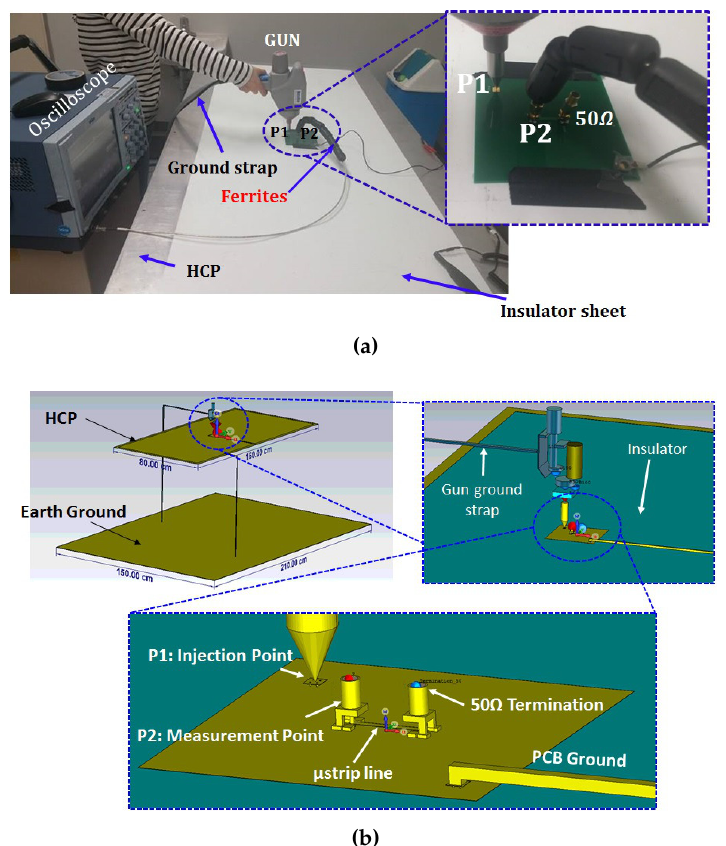
Figure 3. ESD coupled noise analysis for µ -strip line PCB: ( a ) measurement setup as per IEC 61000-4-2 requirements; and ( b ) full-wave EM model of µ -strip line PCB for induced coupling analysis with developed ESD gun